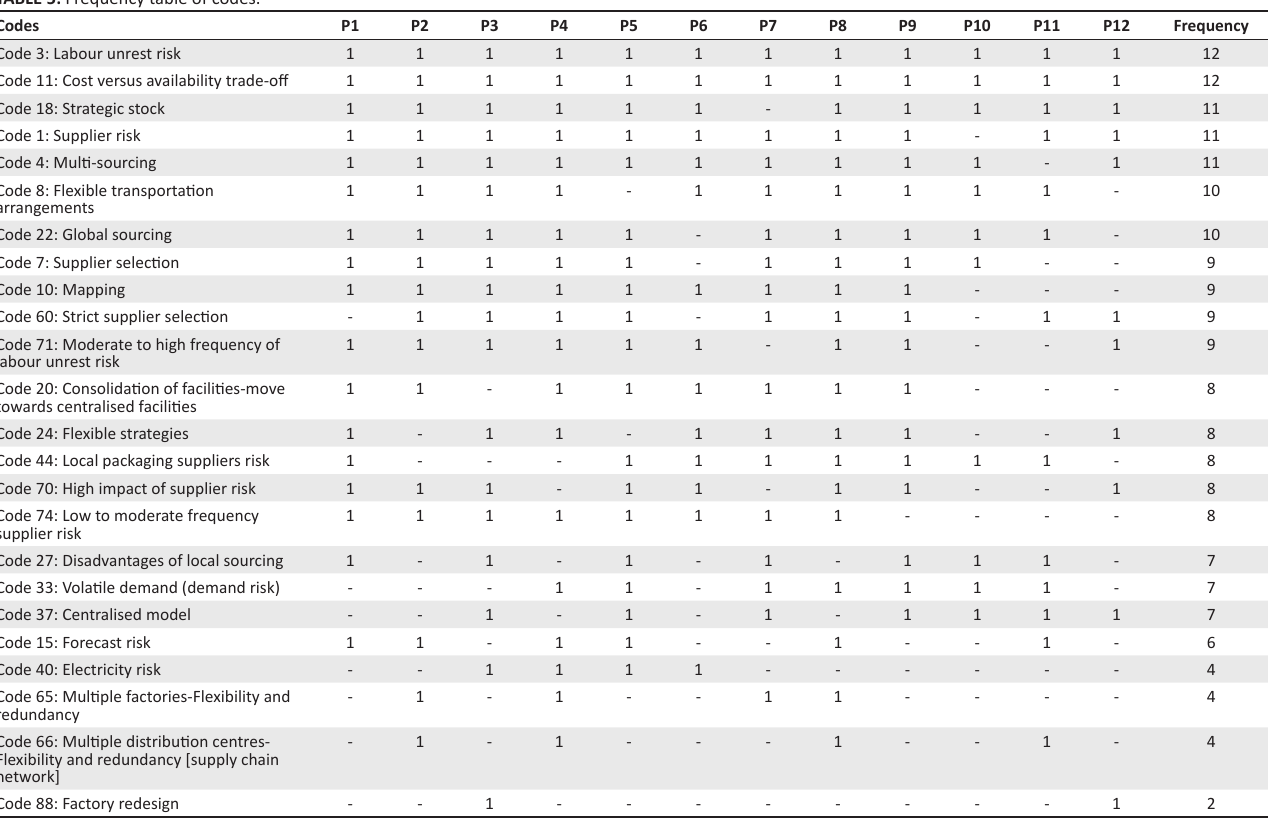
TABLE 5: Frequency table of codes.